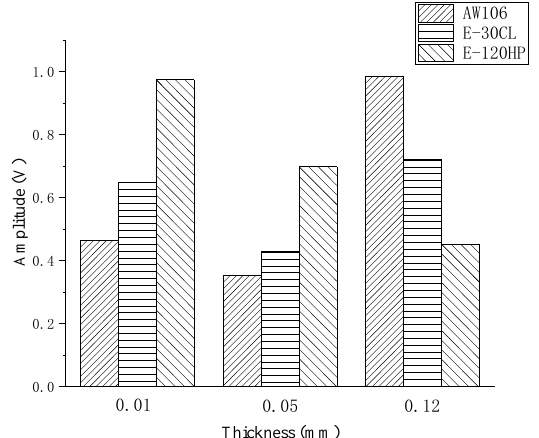
Figure 6. Amplitude extracted from original signal of three kind of adhesives at the thickness of 0.01, 0.05, and 0.12 mm. The excitation frequency is 90 kHz.